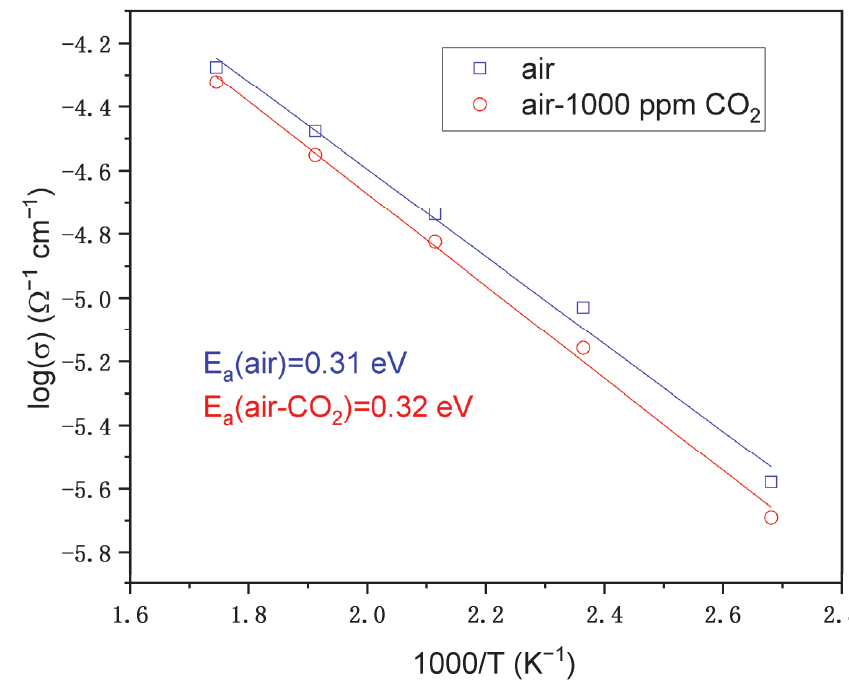
Figure 12. Arrhenius plot of DC conductivity from impedance spectroscopy.